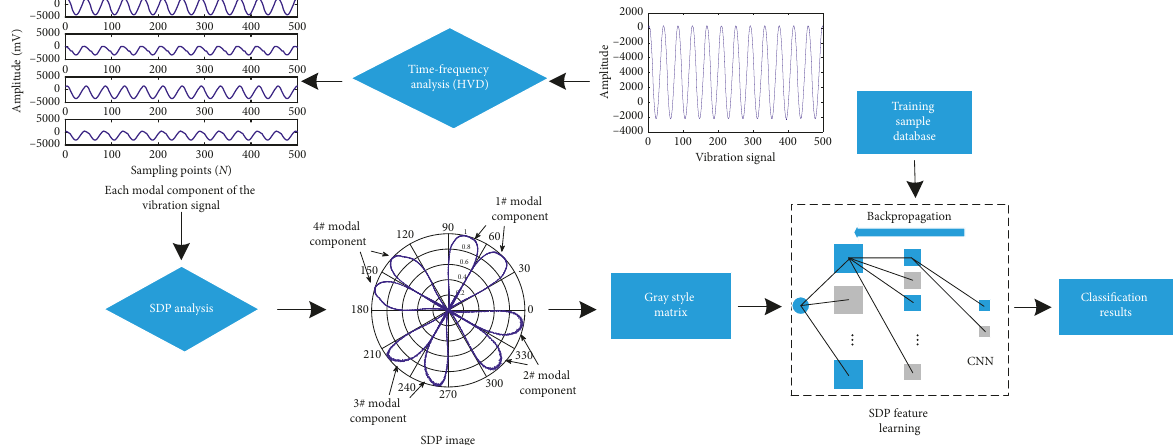
Figure 1: CNN-based vibration signal SDP image identification method. thickness and shape characteristics of the SDP image pattern arms; (3) the geometric center of the SDP image pattern arms; and (4) the SDP image pattern arms point concen-